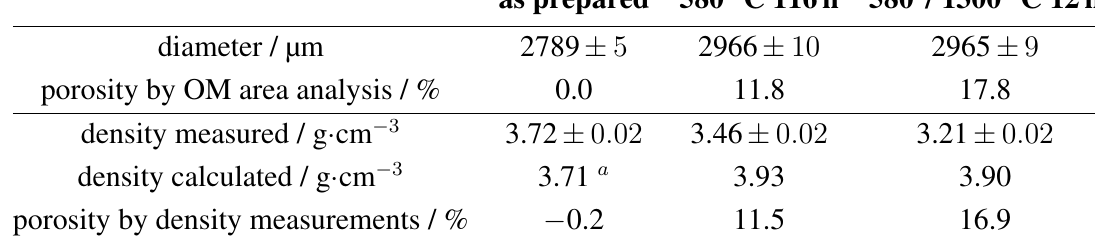
Table 2. Comparison of porosity values measured by OM area analysis in cross section and by density